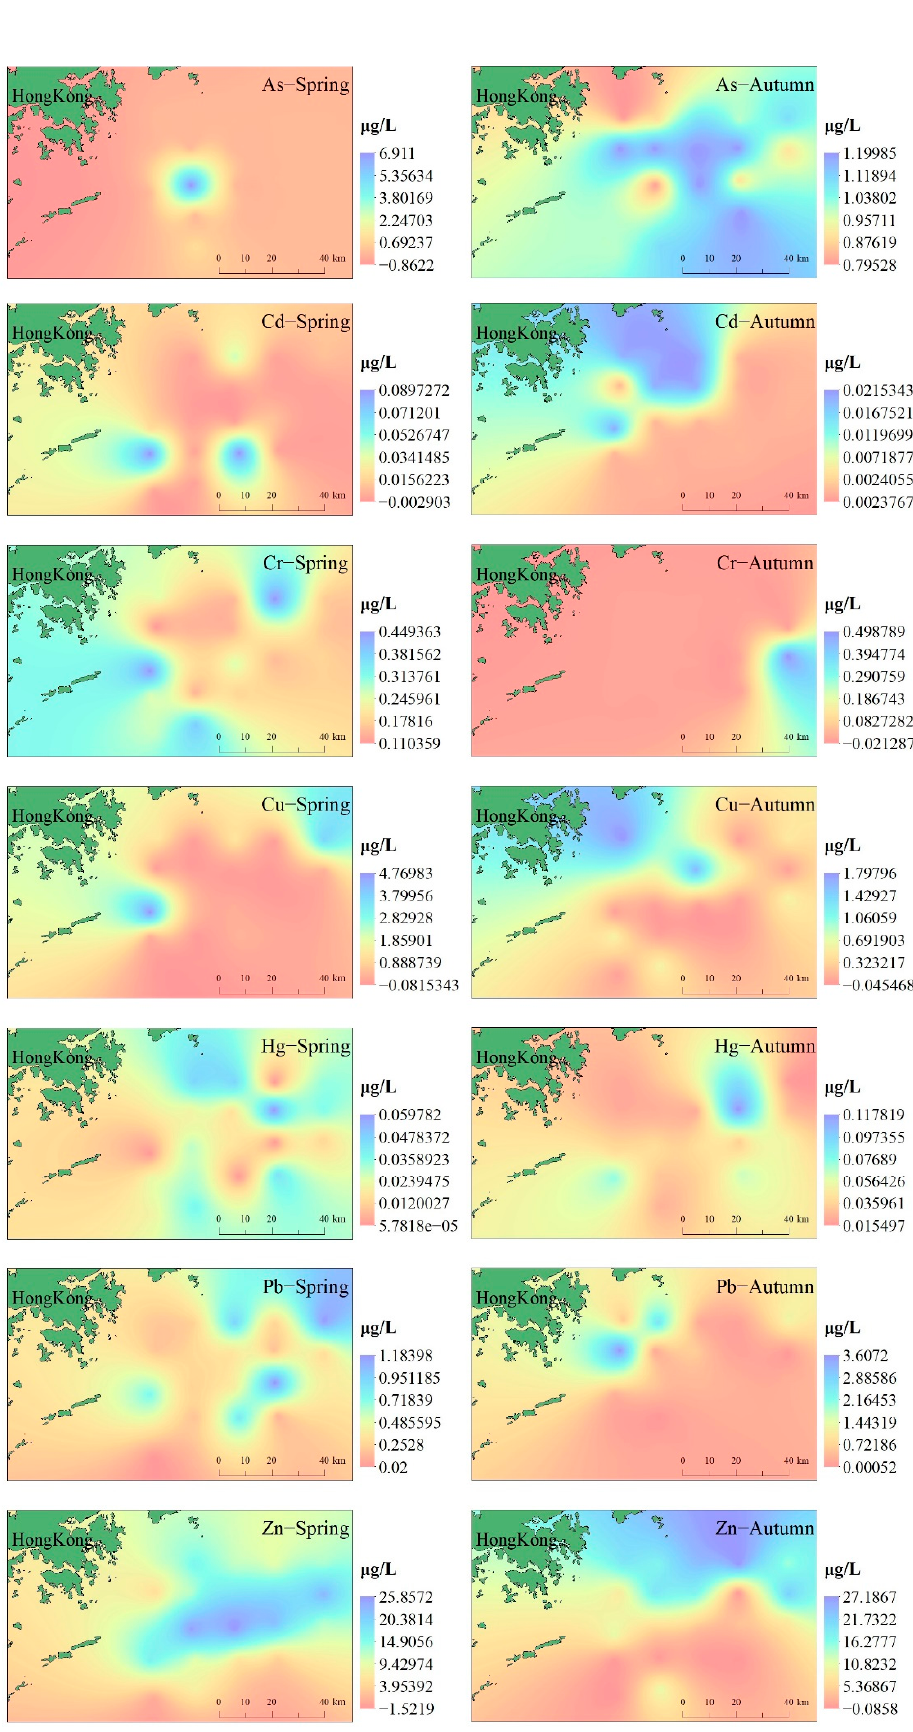
Figure 2. The spatial distribution of heavy metals in seawater.